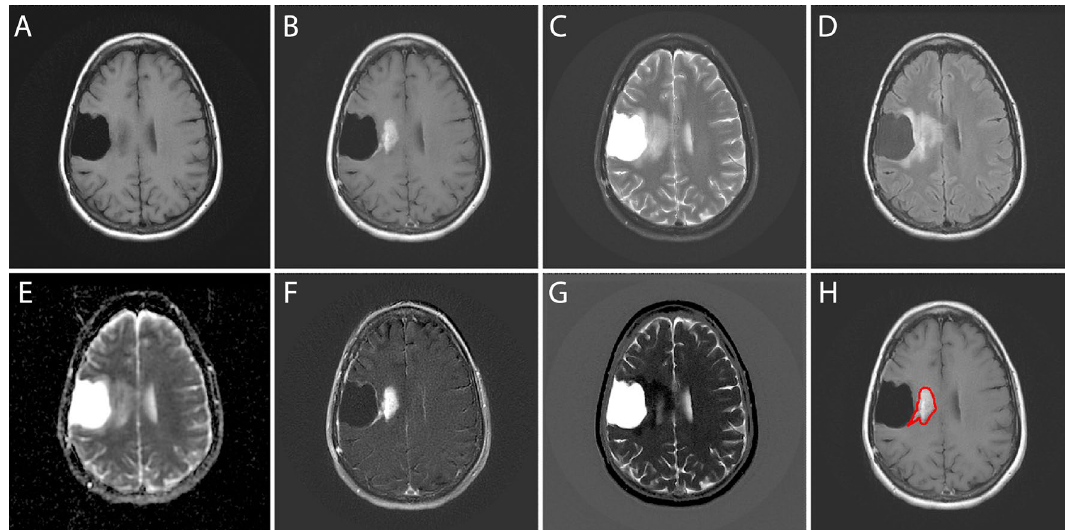
Figure 4. A GBM patient (PsP) with various MRI scans such as ( A ) pre-contrast T1-weighted, ( B ) post- contrast T1-weighted, ( C ) T2-weighted, ( D ) Fluid-Attenuated Inversion Recovery (FLAIR), and ( E ) ADC images. In this study, we included two engineered modalities ( F ) T1post–T1pre and ( G ) T2–FLAIR. And ( H ) the region of interest (ROI) is shown on a post-contrast T1